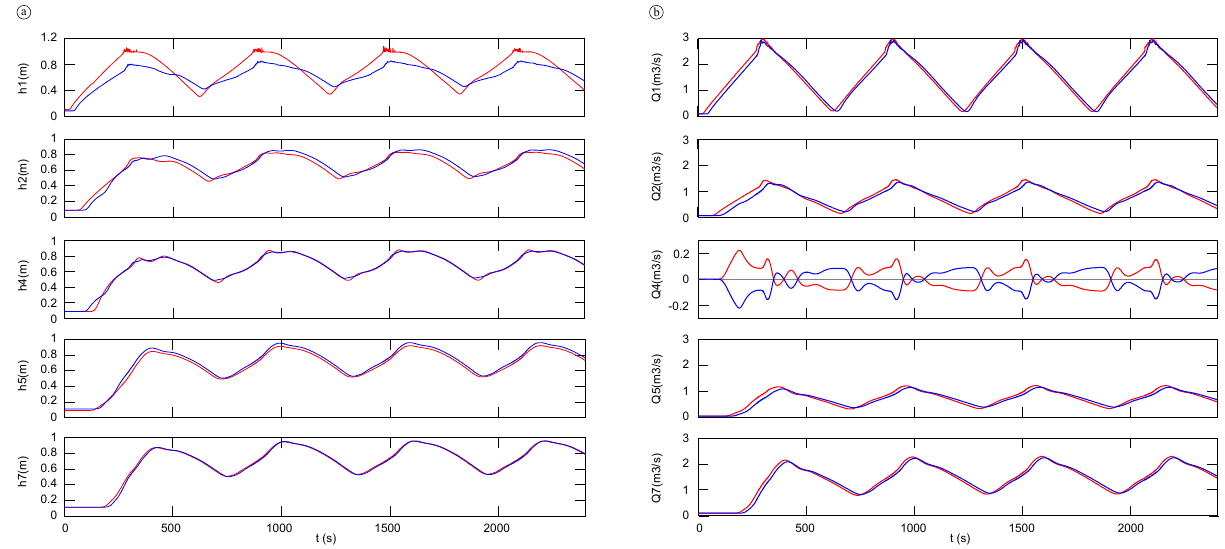
Figure 14. Time histories at grid points i = N / 2 (red) and i = N (blue) for punctually pressurized flow: (a) Water depth; (b) Discharge. The discharge for pipe 4 is recorded at locations i = 1 (red), i = N / 2 (grey) and i = N (blue).